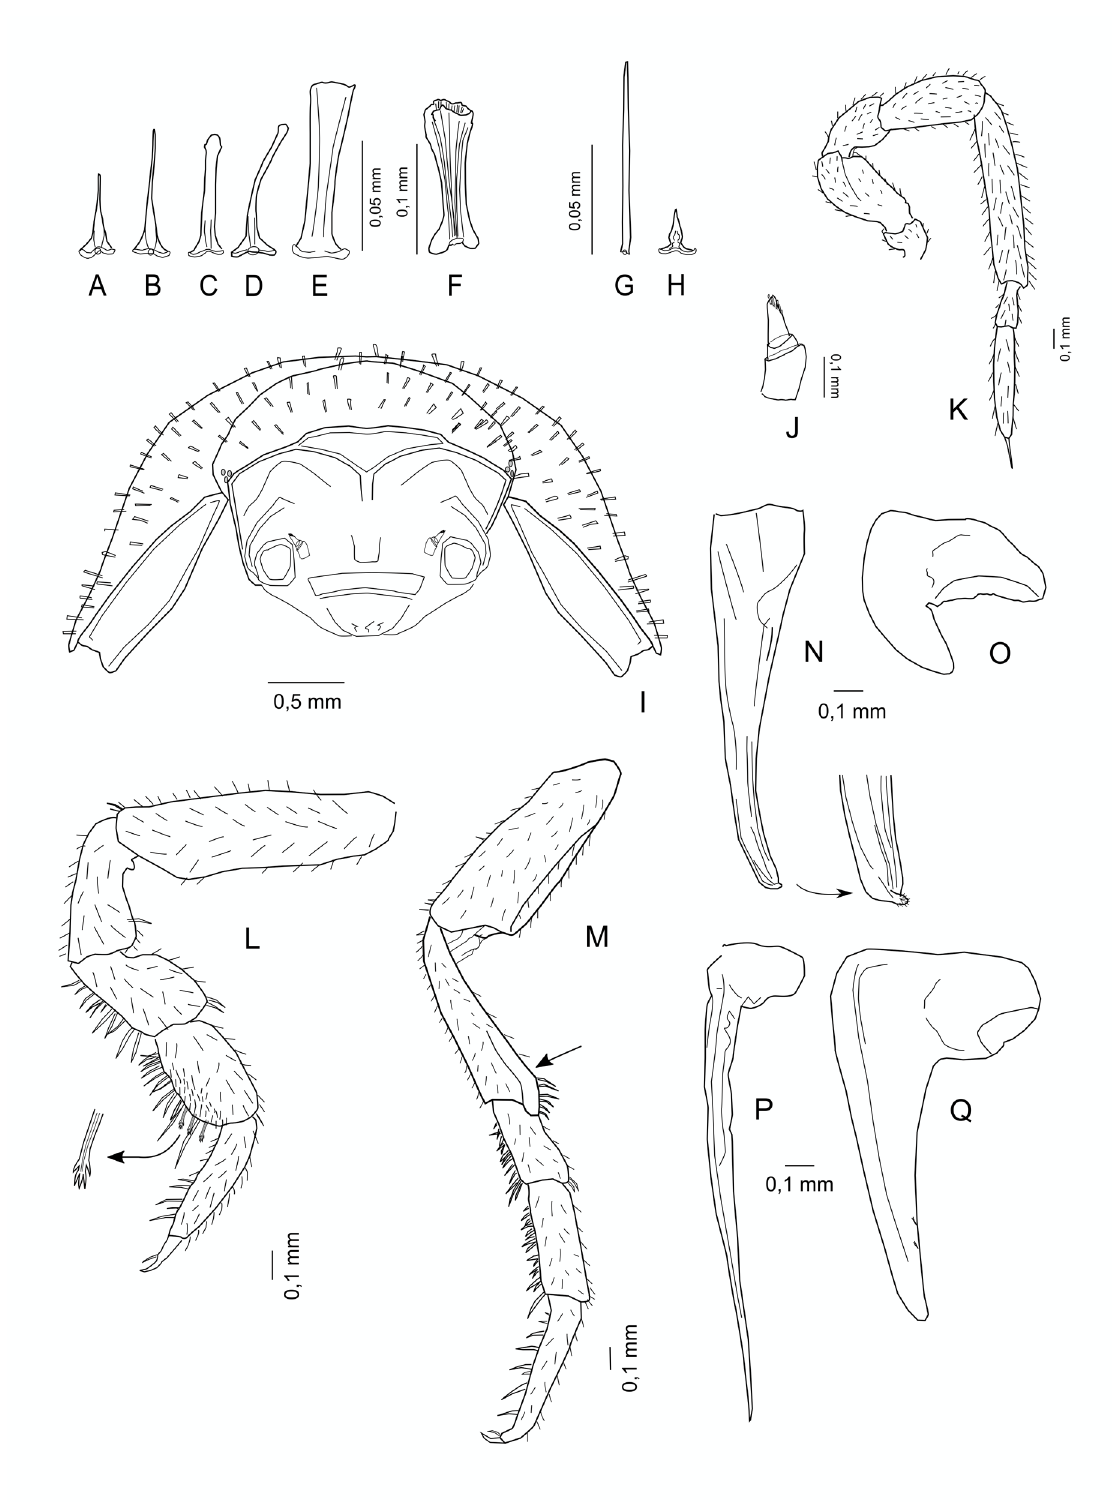
Fig. 4. Eluma matae sp. nov. A–F, I, K–Q . Paratype, ♂ (INV16006). J . Paratype, ♀ (INV16007). A–F . Scale setae. G . E. caelata (Miers, 1877), ♂ (CCZ-UGR852), scale setae. H . E. tuberculata Cruz, 1991, ♀ (INV16004), scale setae. I . Cephalon and first pereonite, frontal view. J . Antennule. K . Antenna. L . Pereopod 1. M . Pereopod 7. N . Endopod I. O . Exopod I. P . Endopod II. Q . Endopod